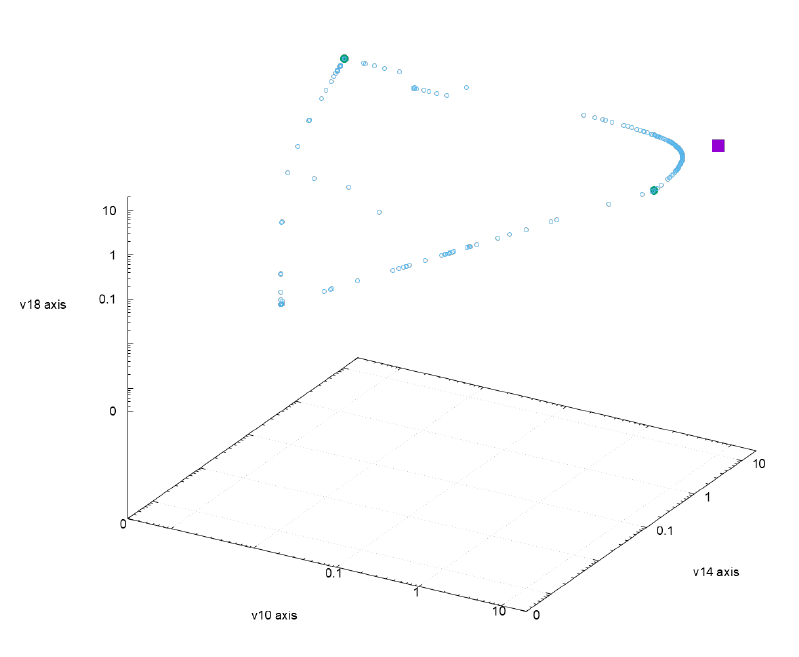
Figure 2. Pareto approximation for configuration C 0 with respect to the objectives ( v 10 , v 14 , v 18 )